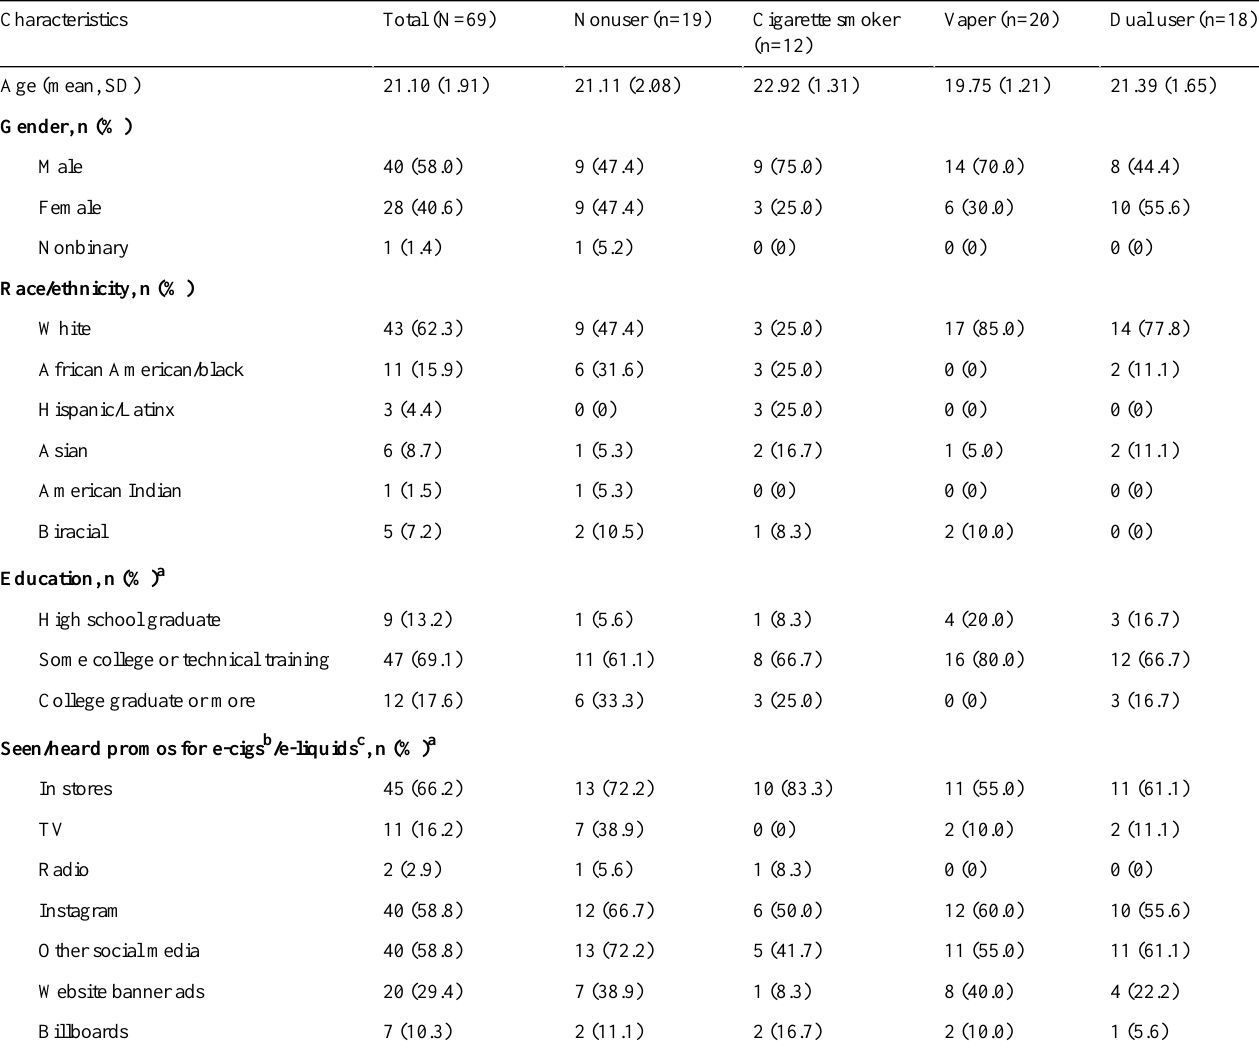
Table 1. Participant characteristics by smoking status.